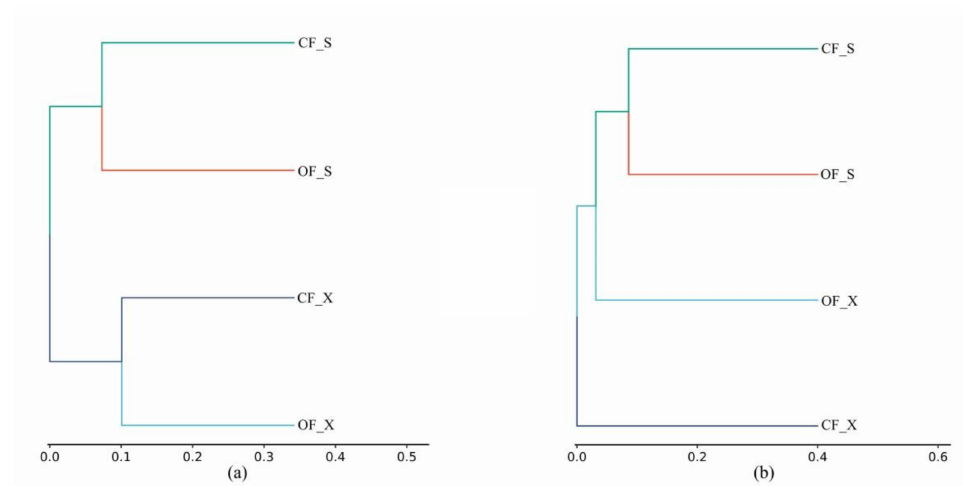
Figure 6. Hierarchical clustering analysis at genus level in ( a ) the bacterial community and ( b ) the fungal